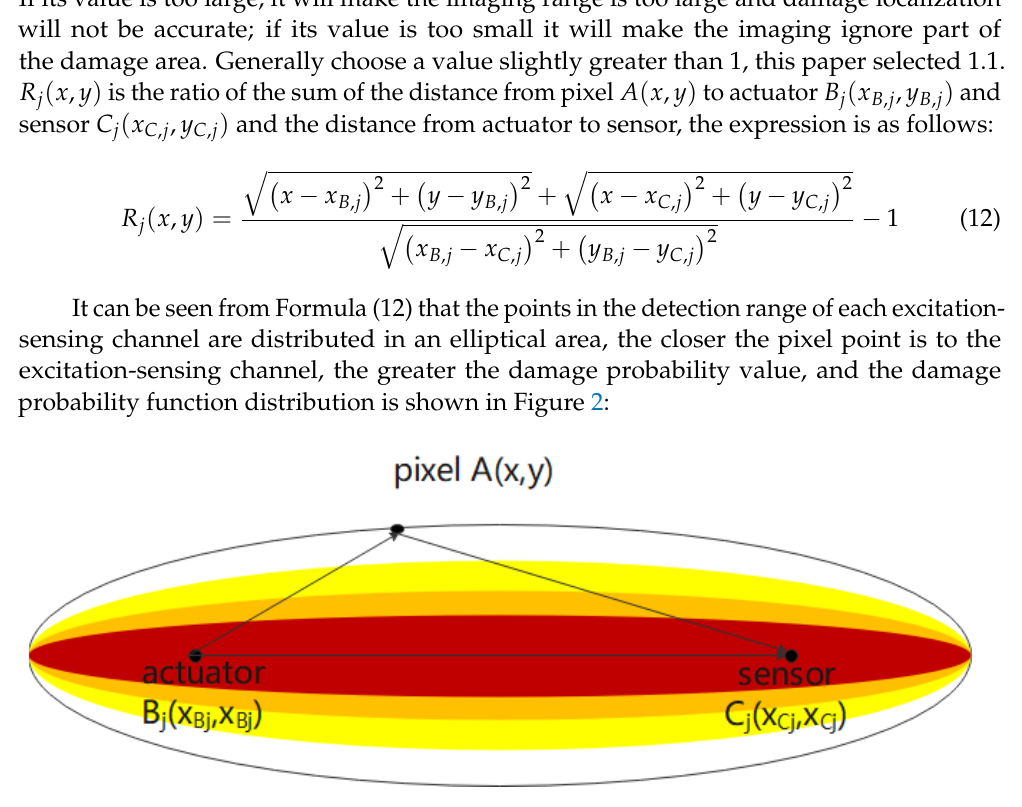
Figure 2. Damage probability function distribution. The darker the color in the ellipse area, the greater the damage distribution probability of the point. Using the Lamb wave sparse representation damage factor proposed in this paper, the fatigue damage imaging of carbon fiber composite materials is realized through the damage probability imaging algorithm. The process is shown in Figure 3. Firstly, the monitored area is uniformly divided into small grids, and each grid represents a pixel point; then the fast block sparse Bayesian learning algorithm is used to make a sparse representation of the Lamb wave signal, and on this basis the damage characteristics are calculated to obtain the damage factor of each channel; finally, the damage probability value of each pixel point is derived by the damage probability imaging algorithm, and the area with the larger damage probability value is the damaged area, and the threshold processing is added to realize the fatigue damage imaging of carbon fiber